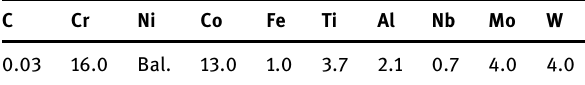
Figure 1. In each run of homogenization, a sample block was put into the heating furnace when the preset homo - genization temperature was reached, and then was taken out for air cooling as long as the preset duration was reached. Homogenization temperatures include 1,140, 1,160, 1,190, 1,220, and 1,240°C, and durations include 5, 10, 20, 25, 30, 40, 50, 70, and 80 h. The sample block was then machined into 15 mm × 15 mm × 15 mm metal - lographic specimens, which were subsequentially pro - cessed by rotary sand paper and polishing cloth, and + HCl + C H OH aqueous solution for etched by CuSO 4 2 5 metallographic observation. Samples for di ff erential scan - ning calorimetry ( DSC ) analysis were Φ 3 mm × 1 mm tiny disks cut from the sample disk, where the DSC temperature rising rate was set to be 10 K · min − 1 . Samples for Gleeble thermal compression were Φ 10 mm × 15 mm columns machined from the sample blocks that have undergone di ff erent homogenization schemes.